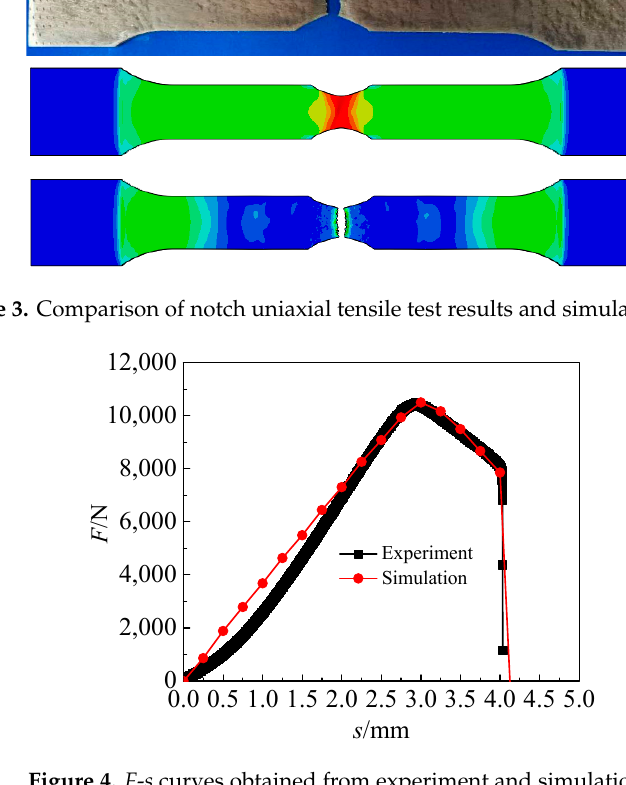
Figure 4. F - s curves obtained from experiment and simulation.